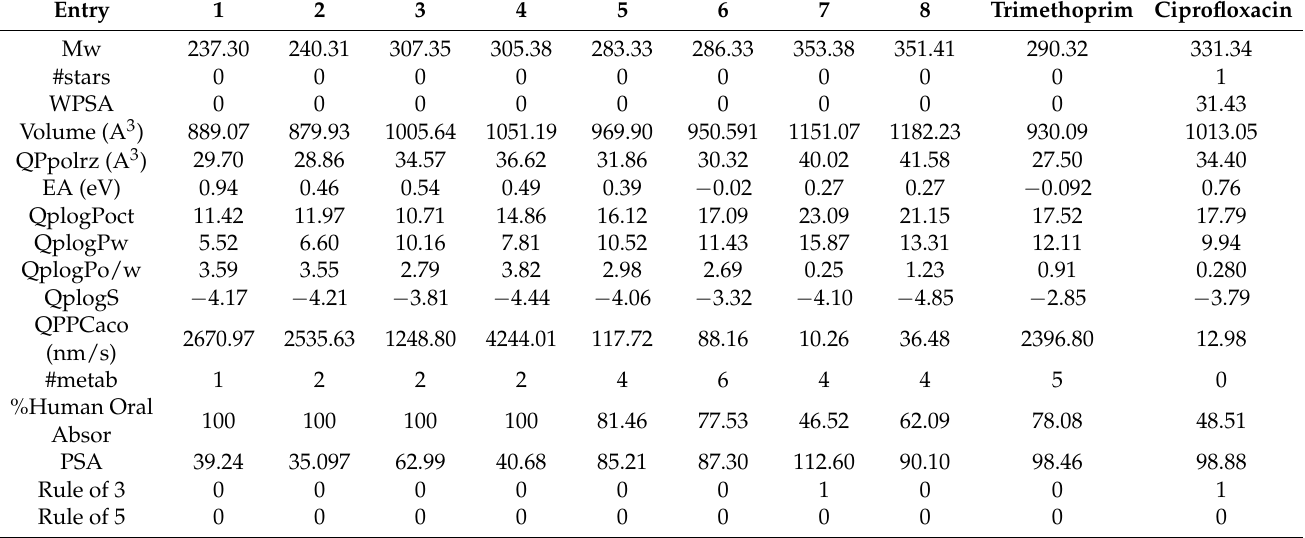
Table 9. ADMET properties of the studied